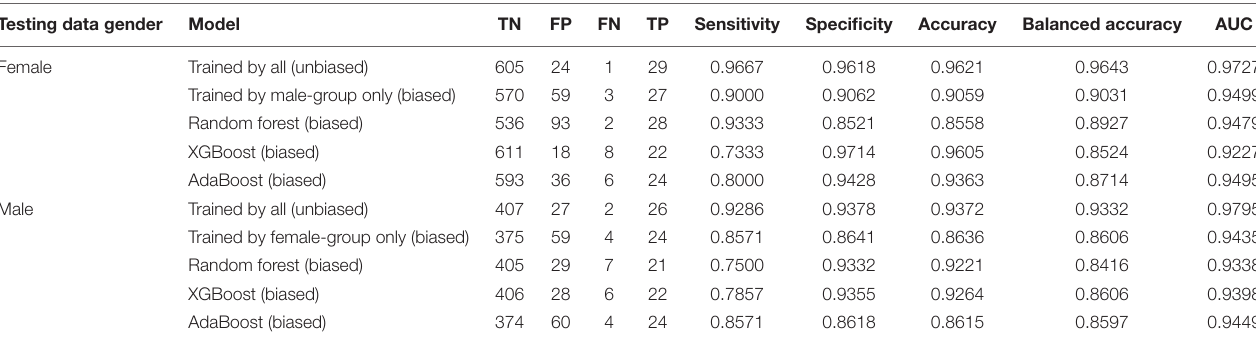
TABLE 5 | Testing data results from different gender data. Testing data